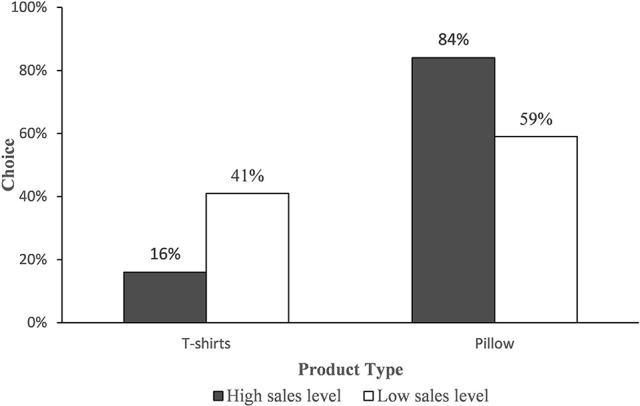
Choice of T-shirts.